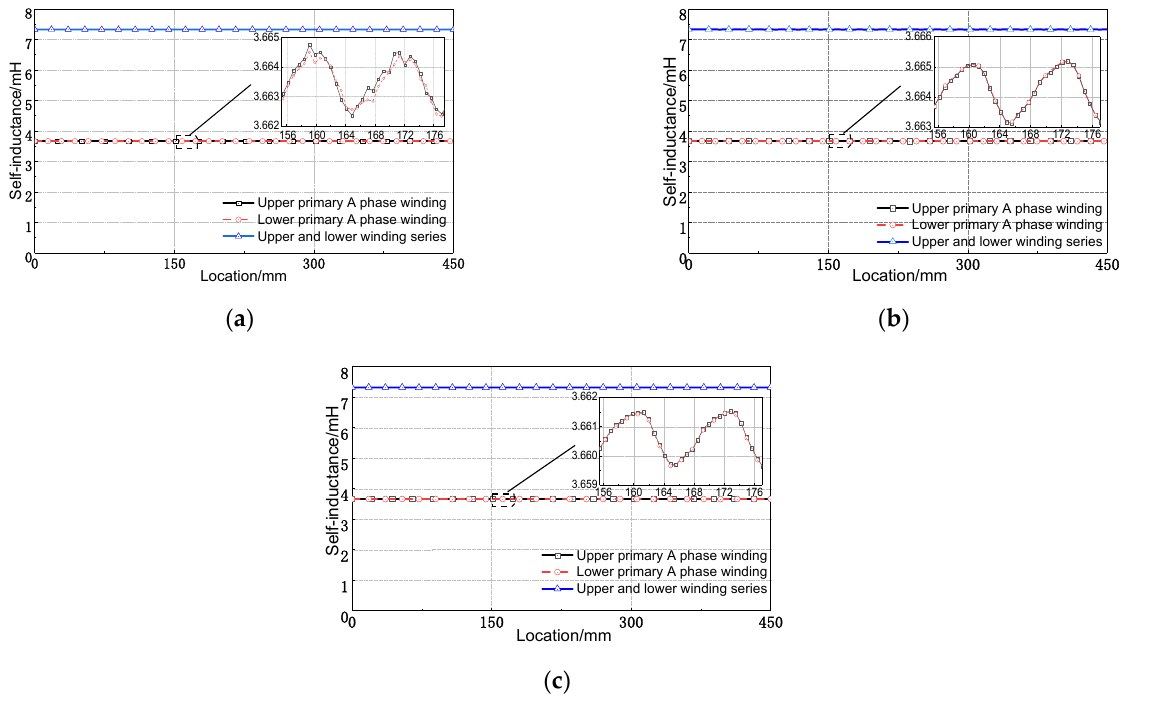
Figure 10. Electromagnetic actuator self-inductance: ( a ) Electromagnetic actuator with radially mag- netized secondary; ( b ) Electromagnetic actuator with Halbach three-section magnetized secondary; ( c ) Electromagnetic actuator with Halbach five-section magnetized secondary. Through the analysis of Sections 3.1–3.4, the performance comparison parameters of three different electromagnetic actuators are obtained, as shown in Table 3. Table 3. Comparison of different electromagnetic actuators.